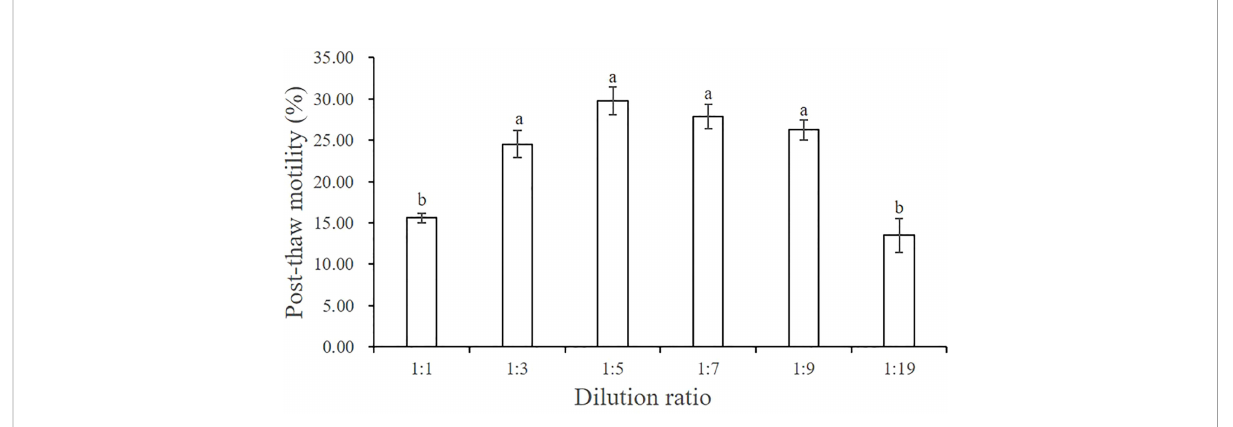
FIGURE 3 Effect of six dilution ratios on the post-thaw motility of A. japonicus spermatozoa. Data are presented as the means ± SE (n = 4). Different letters indicate signi fi cant differences (P < 0.05). Data were not transformed when performing one-way